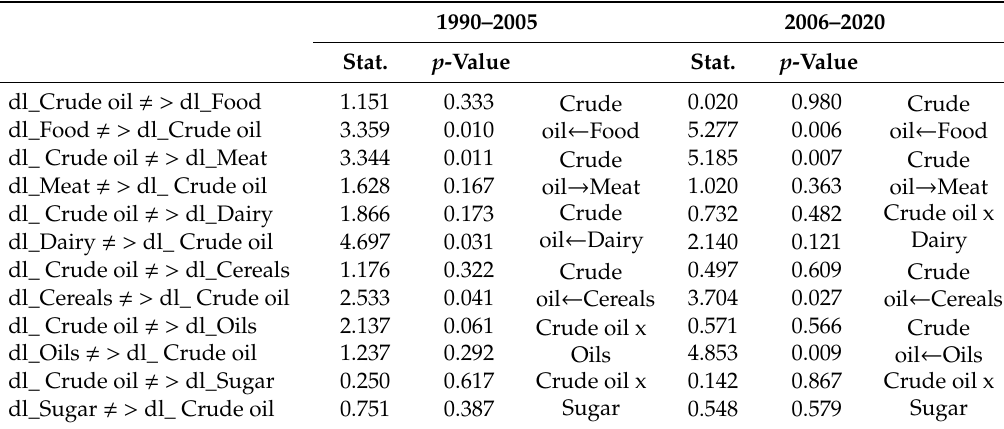
Table 5. Granger causality